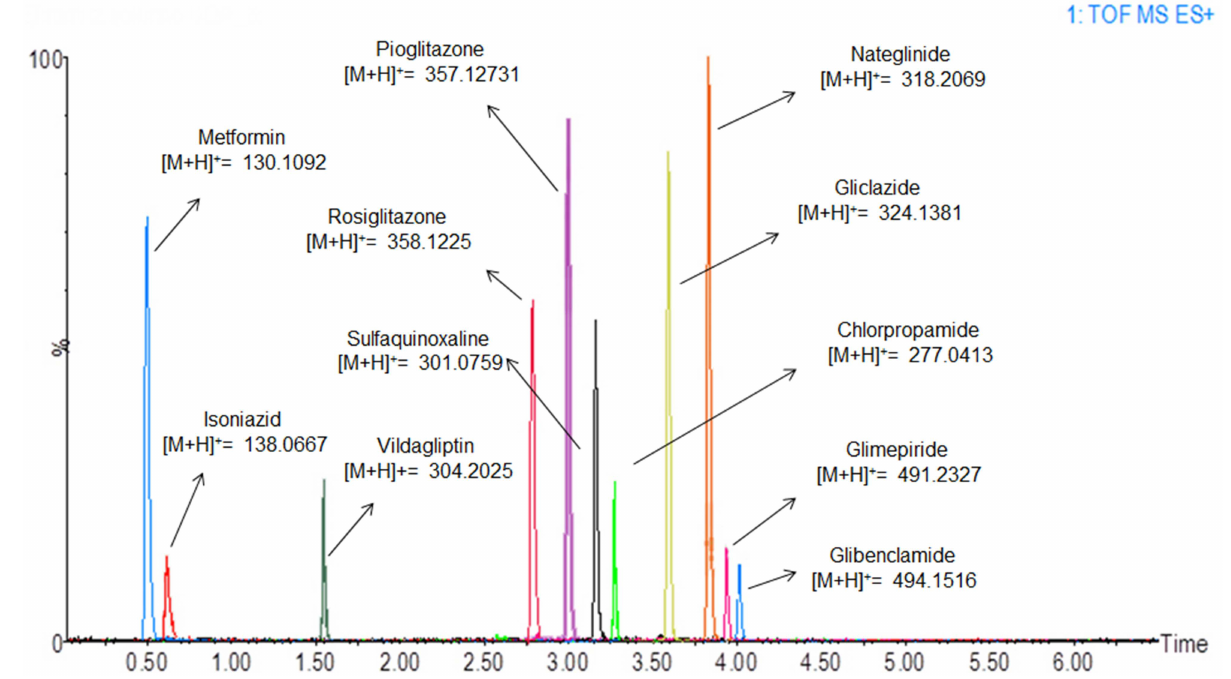
Fig 2. Extracted MS chromatograms of the standards in